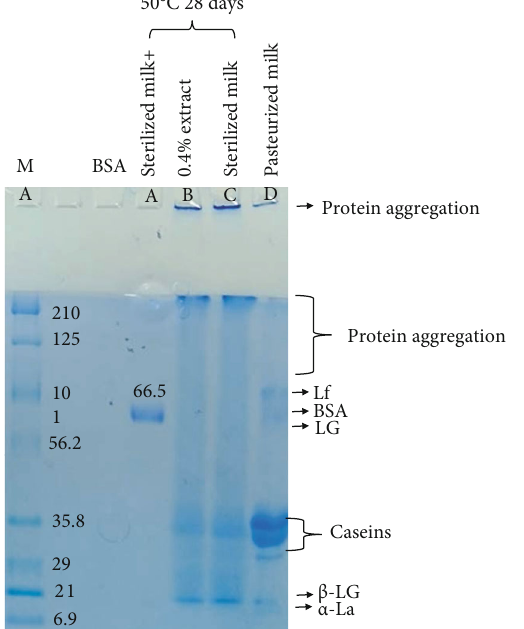
Figure 3: E ff ect of Momordica cochinchinensis aril extract on protein aggregation visualized by SDS-PAGE. The lanes of a marker, BSA, sterilized milk supplemented with 0.4% extract, sterilized milk alone, and pasteurized milk alone are lane A, lane B, lane C, lane D, and lane E, respectively. Lf, BSA, LG, β -LG, and α -LA stand for lactoferrin, bovine serum albumin, lactoglobulin, β -lactoglobulin, and α -lactalbumin, respectively. Table 3: Proximate analysis of sterilized low-fat milk 0.4%.